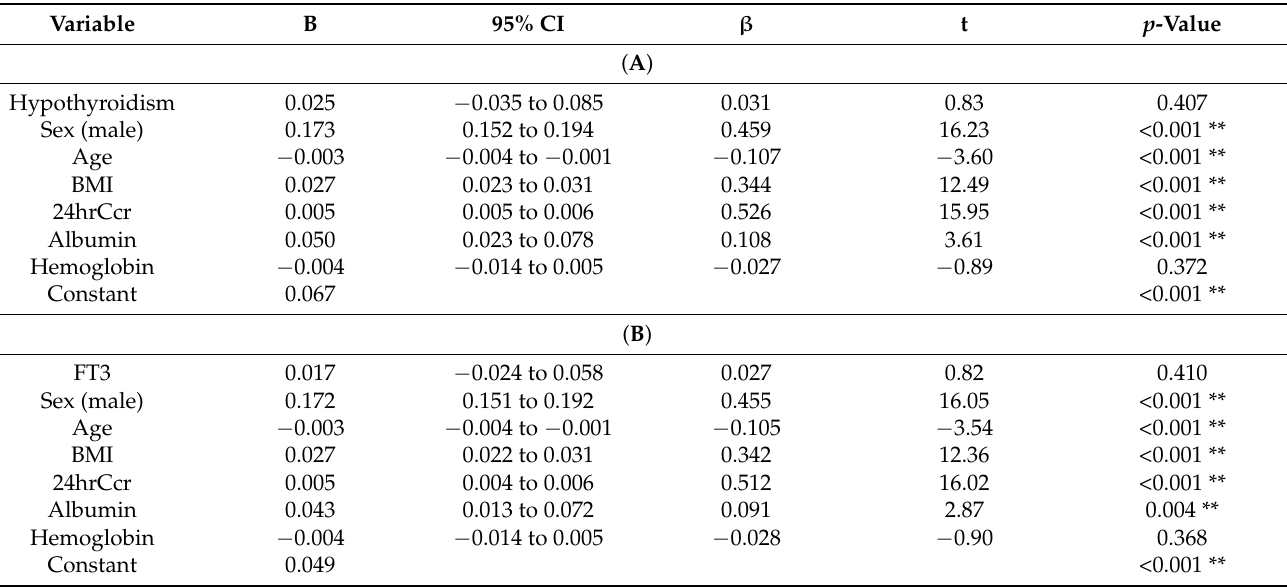
Table 4. Multiple regression analysis of urinary creatinine excretion rate and variables. ( A ) Adjusted for presence of hypothyroidism, sex, age, BMI, 24hCcr, albumin, and hemoglobin. ( B ) Adjusted for FT3, sex, age, BMI, 24hCcr, albumin, and hemoglobin.